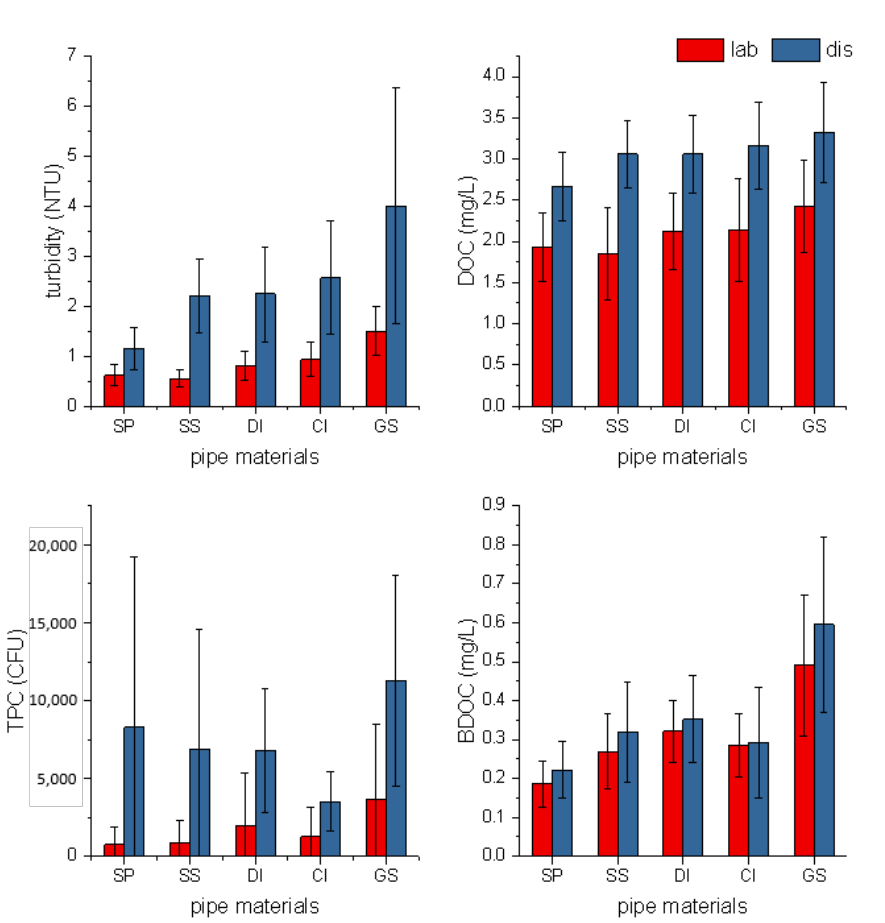
Figure 2. Comparison of effluent from different pipe materials during a seven-day soaking experiment.